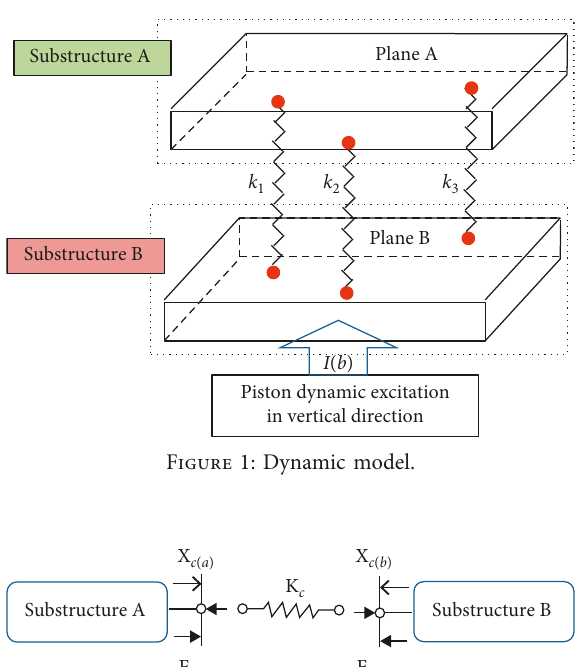
Figure 2: Coupled system with two